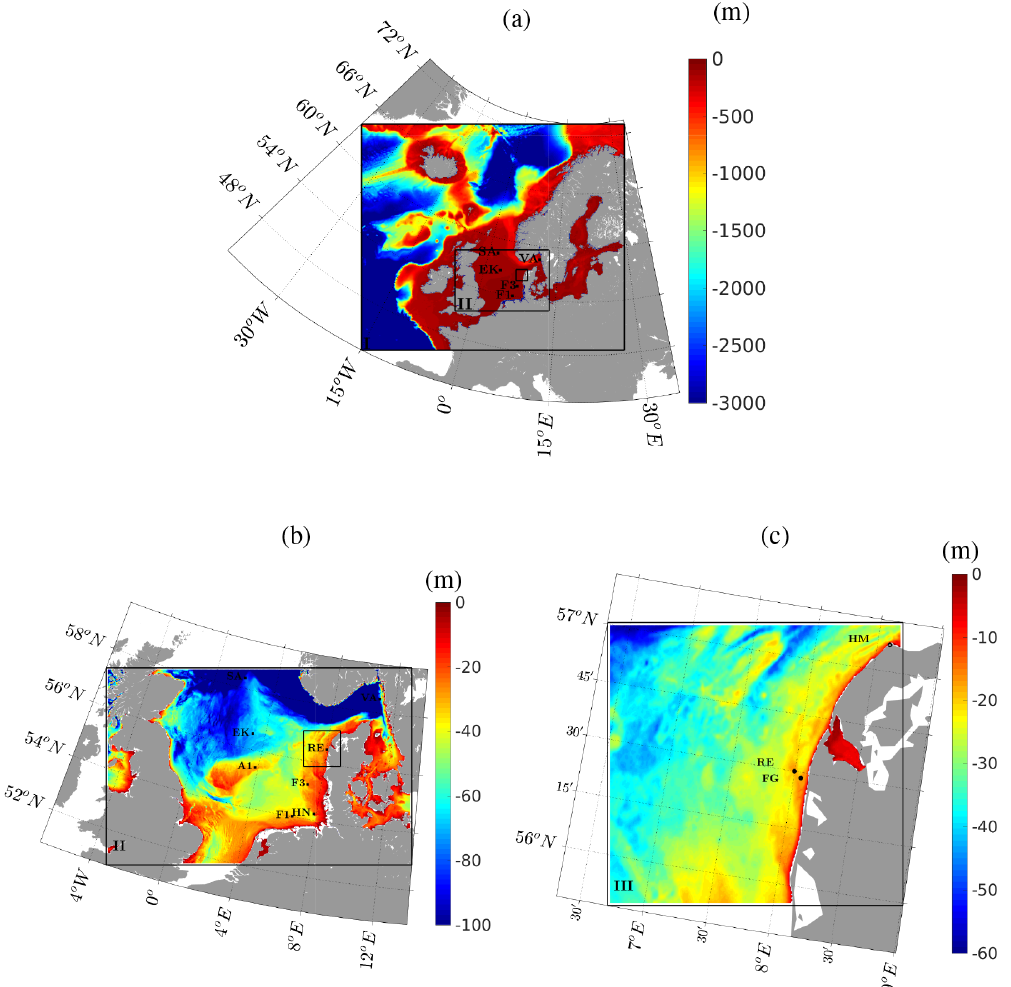
Figure 1. SWAN domain for “Reducing the uncertainty of near-shore wind estimations using wind lidars and mesoscale models” (RUNE) storm simulation, with domains I at 9km resolution, II at 3km resolution, and III at 600m resolution. Panels (a, b, c) show the bathymetry at domain I, II, and III. Bathymetry data are interpolated from EMODnet digital terrain model (DTM) 1 / 8arcmin data. The five measure- ment sites, RUNE (RE), Fjaltring (FG), Hanstholm (HM), A121 (A1), Väderöarna (VA), Heligoland north (HN), Fino-1 (F1), Fino-3 (F3), Sleipner-A (SA), and Ekofisk (EK), are shown as black